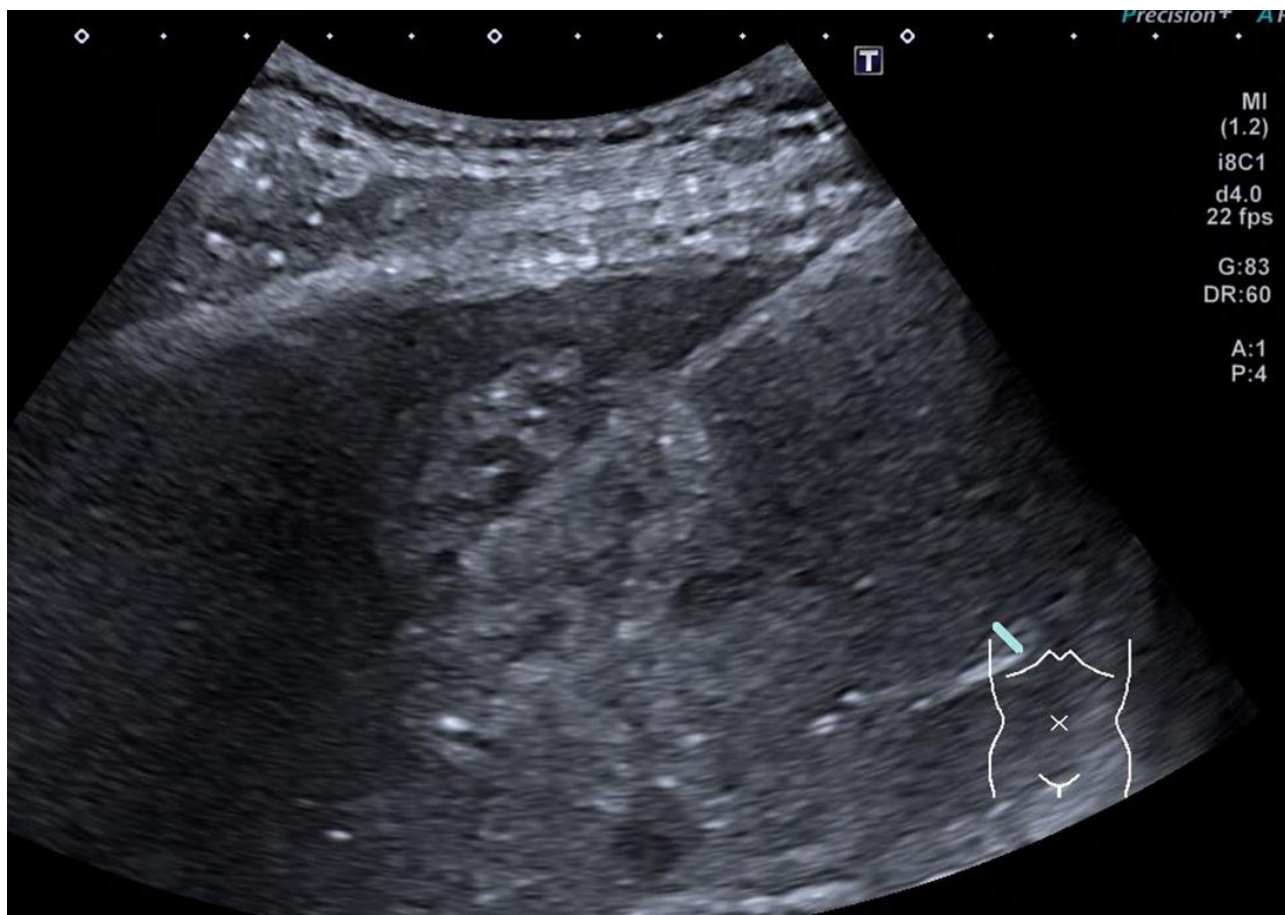
Figure 10. Ultrasound taken during biopsy of the solitary liver lesion, which confirms metastatic disease.